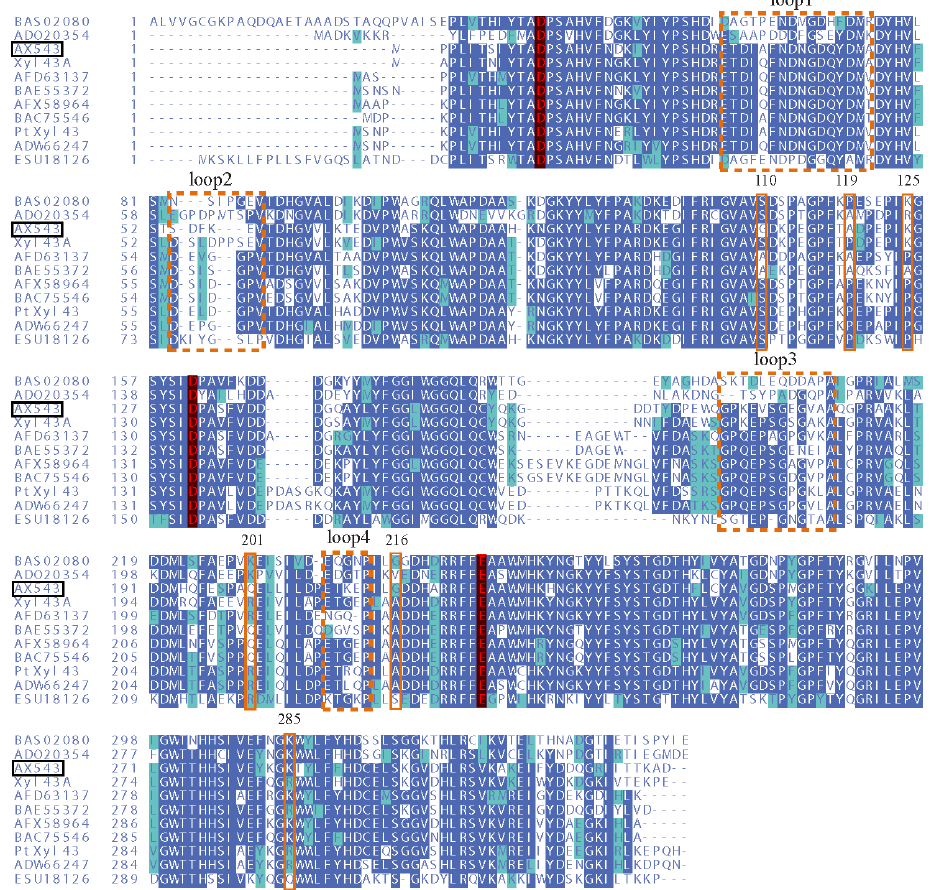
Figure 4. The deduced amino acid sequence alignment of AX543 (ON730957) and the reference family GH43 β -xylosidases. They are Xyl43A from Humicola insolens (AHC72382.1), PtXyl43 from